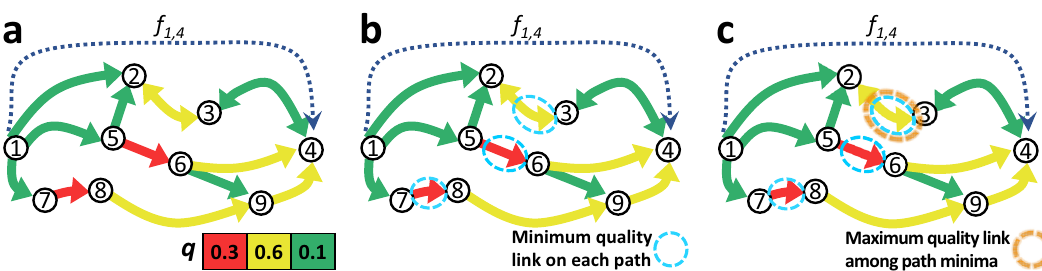
Fig. 3 Finding the limiting link between an origin-destination node pair. a A small network with color-coded link qualities q , where as an example, we demonstrate the process to identify the limiting link between the O – D node pair (1,4) having a directed fl ow demand of f 1,4 . b The available paths from node 1 to node 4 (and path ’ s minimum-quality link) are 1 → 2 → 3 → 4 ( e 2,3 ), 1 → 5 → 2 → 3 → 4 ( e 2,3 ), 1 → 5 → 6 → 4 ( e 5,6 ), 1 → 5 → 6 → 9 → 4 ( e 5,6 ), 1 → 7 → 8 → 9 → 4 ( e 7,8 ). c Among the minimum-quality links on these paths, e 2,3 has the maximum quality. Just below the threshold ρ = 0.6, still, two paths connect node 1 to node 4, but then with e 2,3 removed, node 4 becomes unreachable from node 1 on G 0.6 . The limiting link associated with node pair (1,4) is e q fl ow from node 1 to node 4 is constrained to interfere with. The ratio of f 2,3 , thus, an increase in 2,3 will increase the lowest quality that the 1,4 to the total demand, is added to criticality score s 2,3 of the link e 2,3 to re fl ect the importance of its quality q 2,3 for fl ow movement over the network.